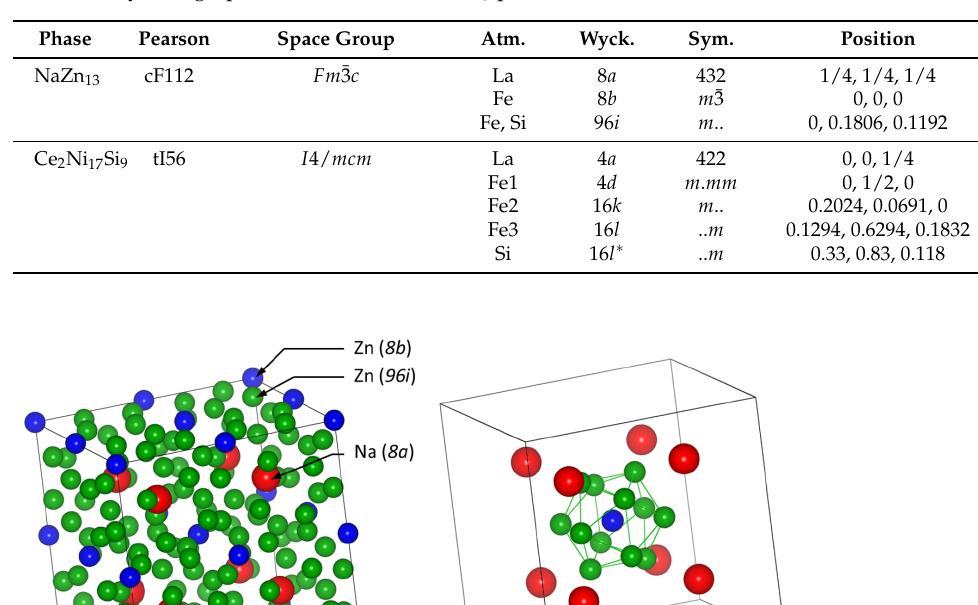
Table 1. Crystallographic data of the La(Fe,Si) 13 phases [34].